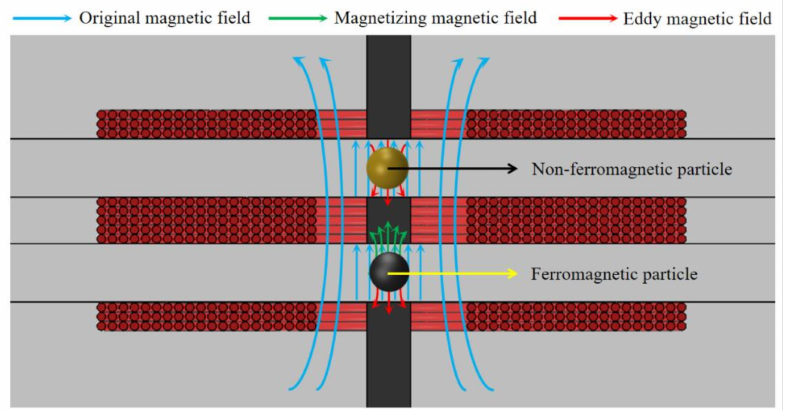
Figure 3. Schematic diagram of sensor detection